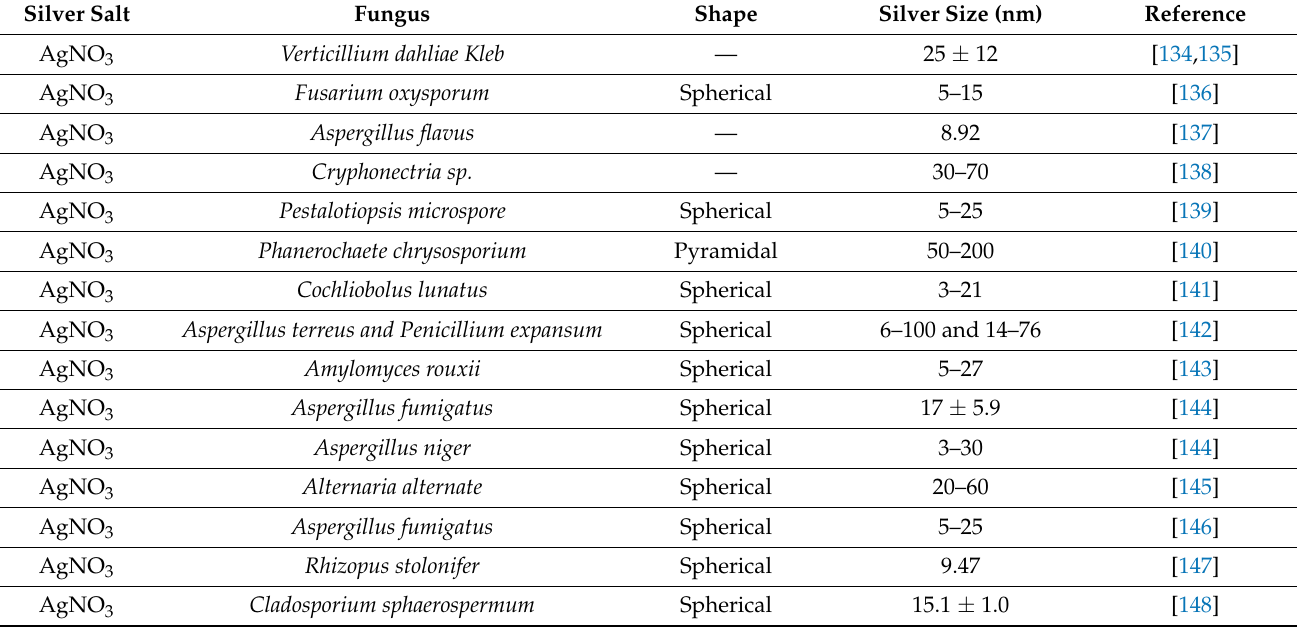
Table 7. Synthesis of AgNPs using fungus.